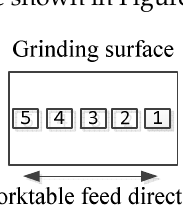
Figure 3. Schematic diagram of measuring position for ground surface roughness.